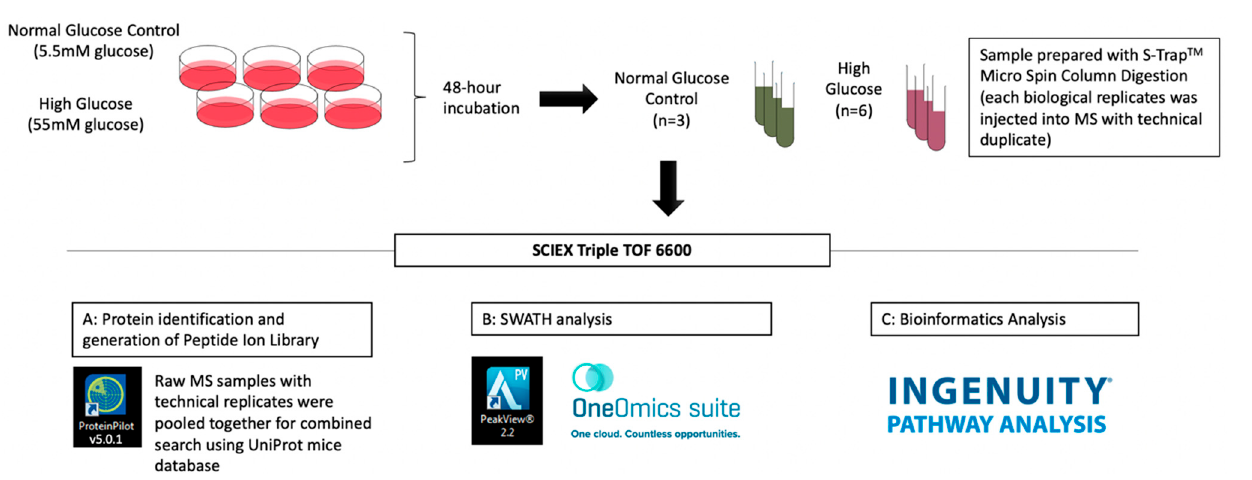
Figure 7. Schematic flowchart of the liquid chromatography-tandem mass spectrometry (LC-MS/MS) experiment of 661w cells incubated in high glucose vs. the normal glycemic control.